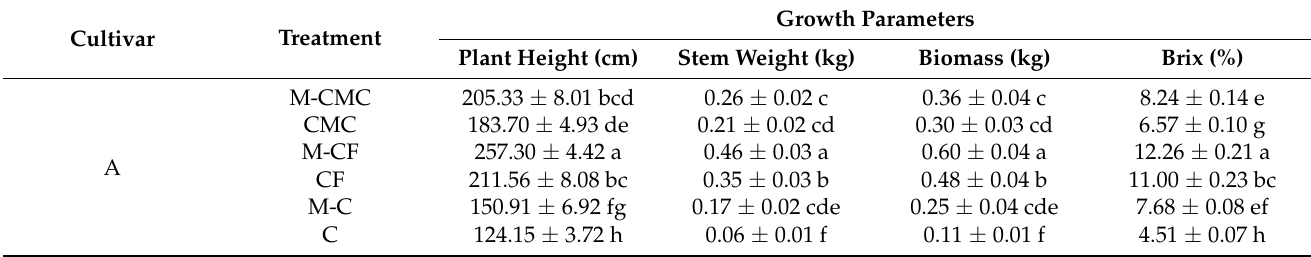
Table 1. Growth parameters and sugar content (brix%) of sweet sorghum cultivars under mulching and fertilizer